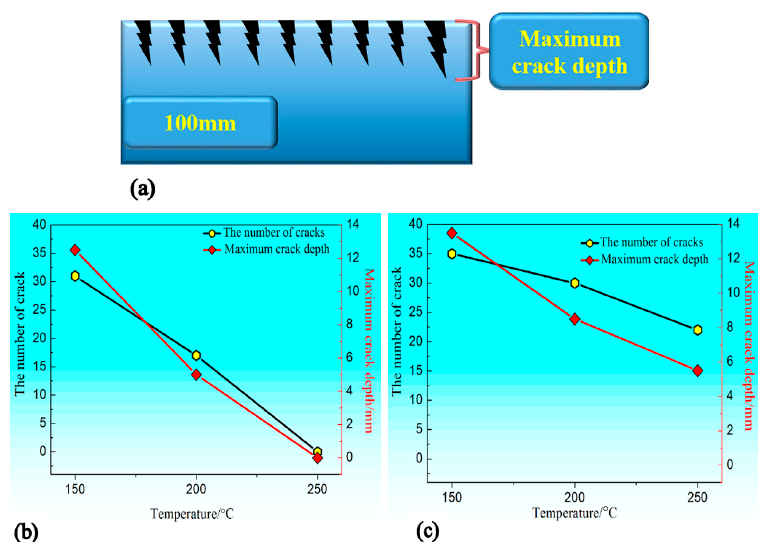
Figure 4. ( a ) Schematic showing counting of the crack numbers and measure the maximum crack depth, and the statistical data of the number of edge cracks and maximum crack length at different temperature for ( b ) on-line heating rolling and ( c ) conventional rolling.